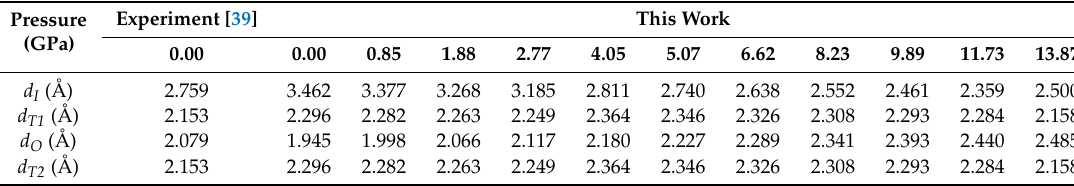
Table 3. Compared with experimental values, the average layer thickness and interlayer thickness of pyrophyllite [Al 4 Si 8 O 20 (OH) 4 ] at 0 GPa and that of given pressures.